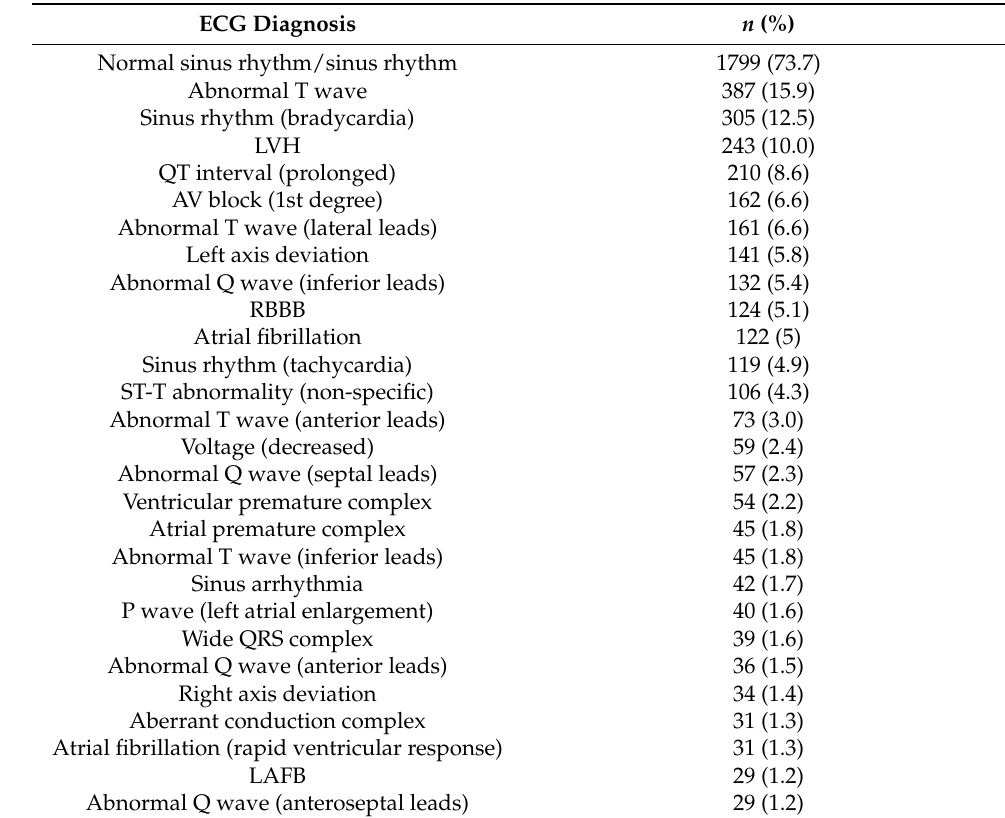
Table A2. Prevalence of ECG diagnosis (prevalence >